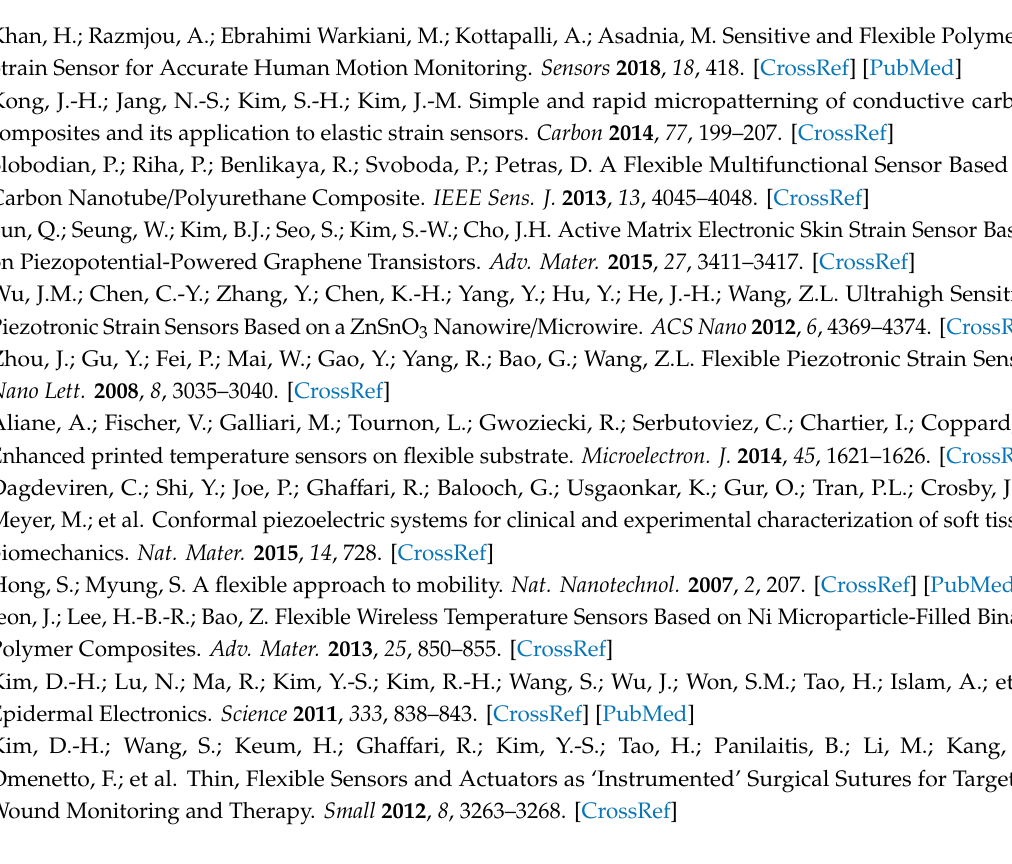
Figure S1: Reproducibility of the FEP encapsulated sensor; Figure S2: FIB Image of a crack on the sensor’s surface; Figure S3: (a) Schematic illustration of wire-connecting method. (b) Schematic illustration of wire-connected FEP encapsulated sensor; Figure S4: Gauge Factor variation of sensors with di ff erent length. (Percentage calculated from a sample with 50 mm length); Figure S5: Gauge Factor variation of sensors encapsulated by 25 µ m FEP films and 50 µ m FEP films that have been in water for 18 days; Figure S6: Resistance variation of bare crack sensor that have been in water for 32 h; Figure S7: Gauge Factor variation of sensors encapsulated by 25 µ m FEP films and 50 µ m FEP films that have been in chromium etchant for 14 days; Figure S8: Gauge Factor variation of the sensor encapsulated by 25 µ m FEP films from 25 ◦ C to 75 ◦ C; Table S1: Sample size, Mean and Standard deviation of the resistance variation data from finger motion test in Figure 4c; Figure S9: (a) Resistance variation of the sensor encapsulated with the 25 µ m FEP film during the finger motion test. (b) Shows a small-scale plot for the wire shaking; Figure S10: (a–d) Measurement of finger’s motions using the sensor encapsulated with the 25 µ m FEP film that have been soaked in water for 9 days. (f–i) Measurement of pulse rate using the sensor encapsulated with the 25 µ m FEP film that have been soaked in water for 9